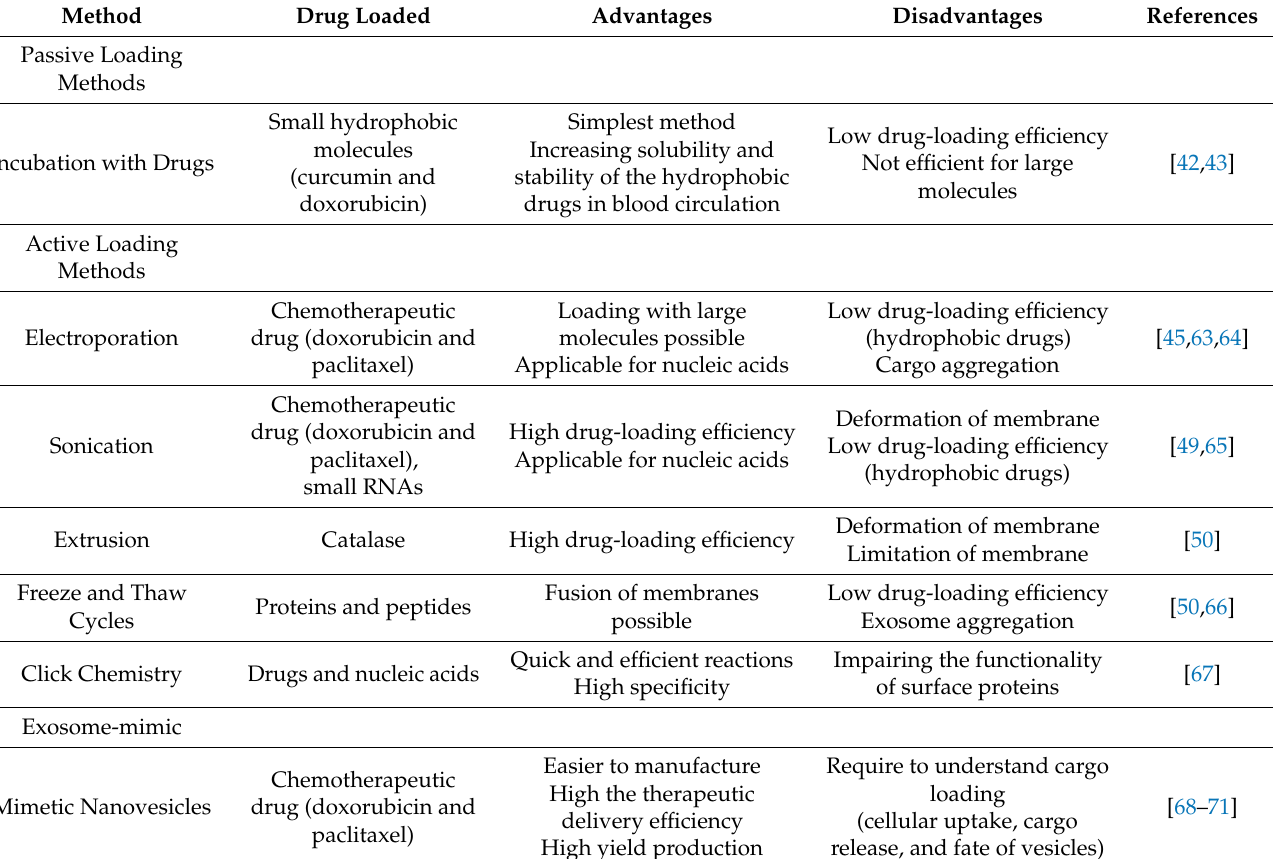
Table 1. Studies for the loading of therapeutic molecules into